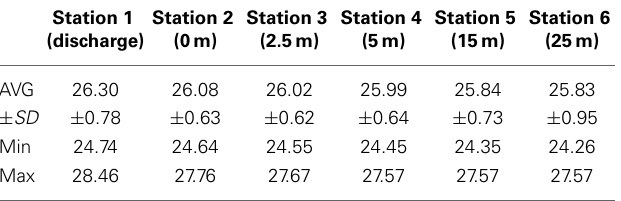
Table 1 | Temperature data (HOBO Pendant ® Temperature Data Loggers) from all transect stations.